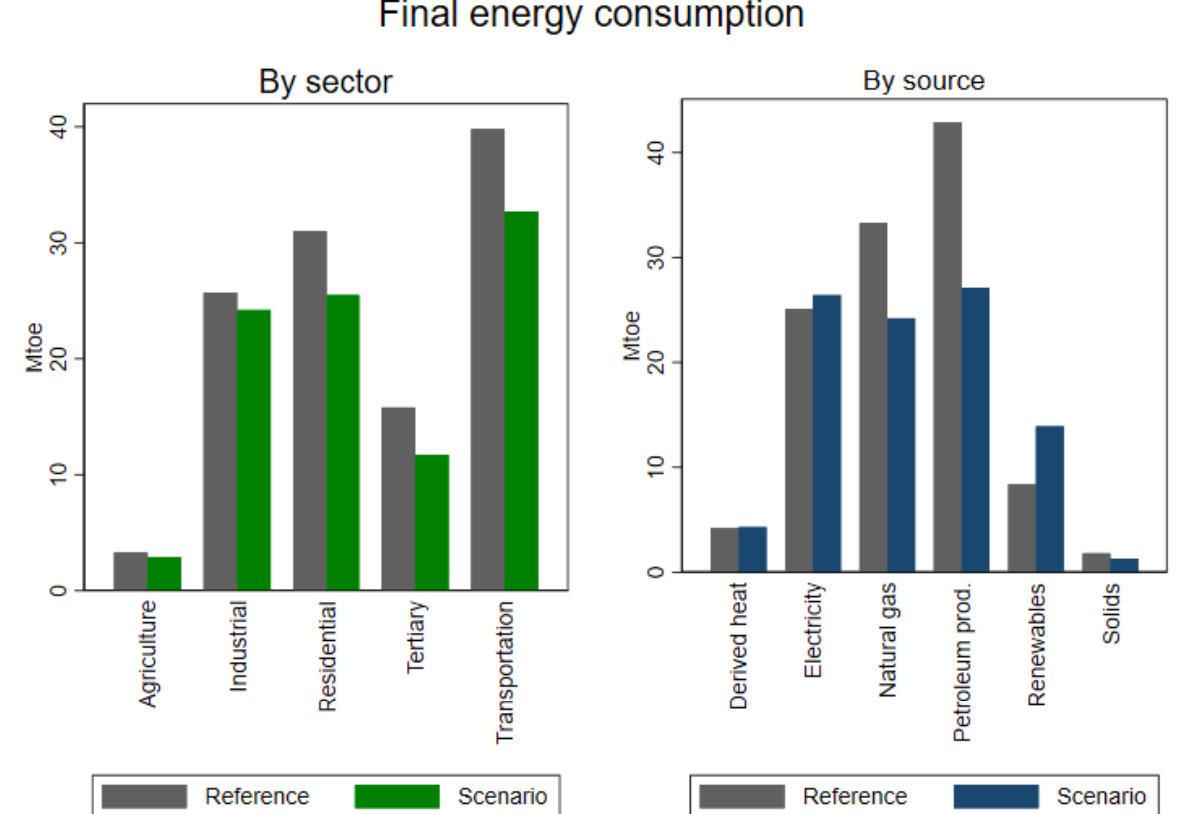
Figure 2. Final energy consumption by source. Note that the scenario refers to a 19% reduction, as shown in Figure 1. Table 1. Primary energy consumption